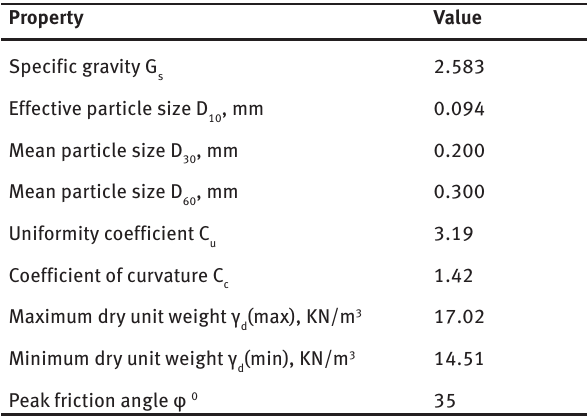
Table 1: Geotechnical properties of the tested sand.